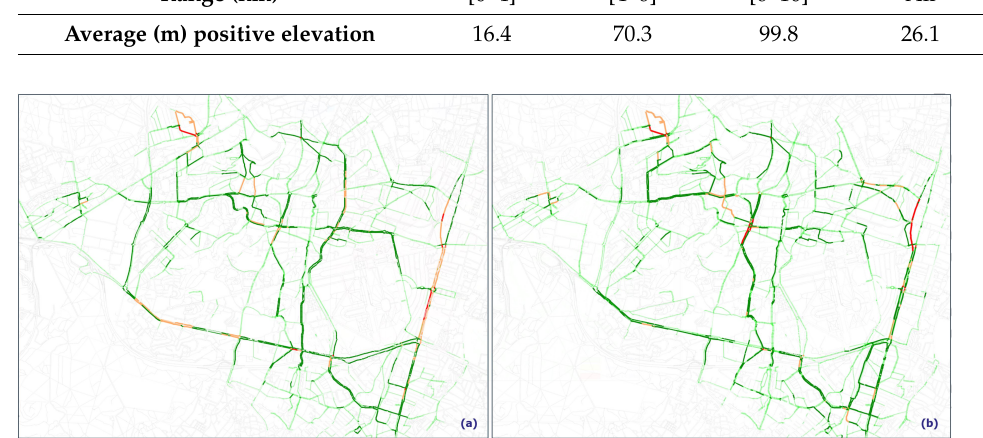
Figure 8. Main bicycle flows in standard scenario ( a ), and the extension scenario ( b